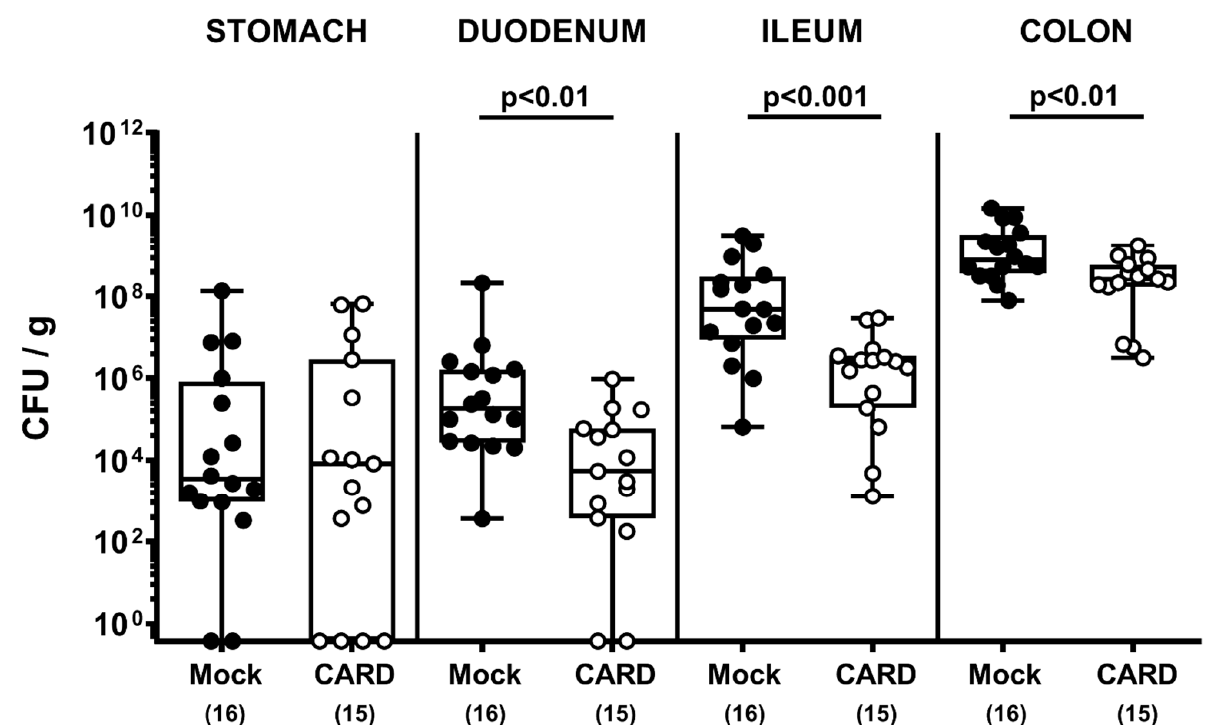
Figure 1. Gastrointestinal pathogen loads following oral cardamom essential oil application to Campylobacter jejuni - ( C. jejuni -) infected microbiota-depleted IL-10 − / − mice. Microbiota-depleted IL-10 − / − mice were infected with C. jejuni strain 81–176 on days 0 and 1 by gavage and perorally challenged with cardamom essential oil (CARD; white circles) via the drinking water starting on day 2 post-infection, whereas mock control mice received vehicle (black circles). Gastrointestinal